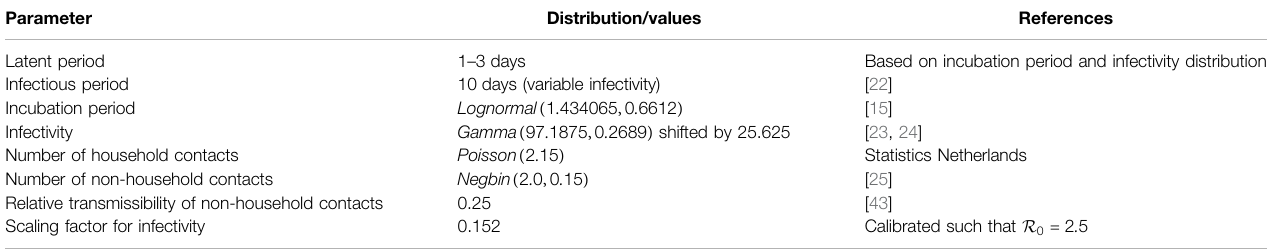
TABLE 1 | Disease and transmission parameters.